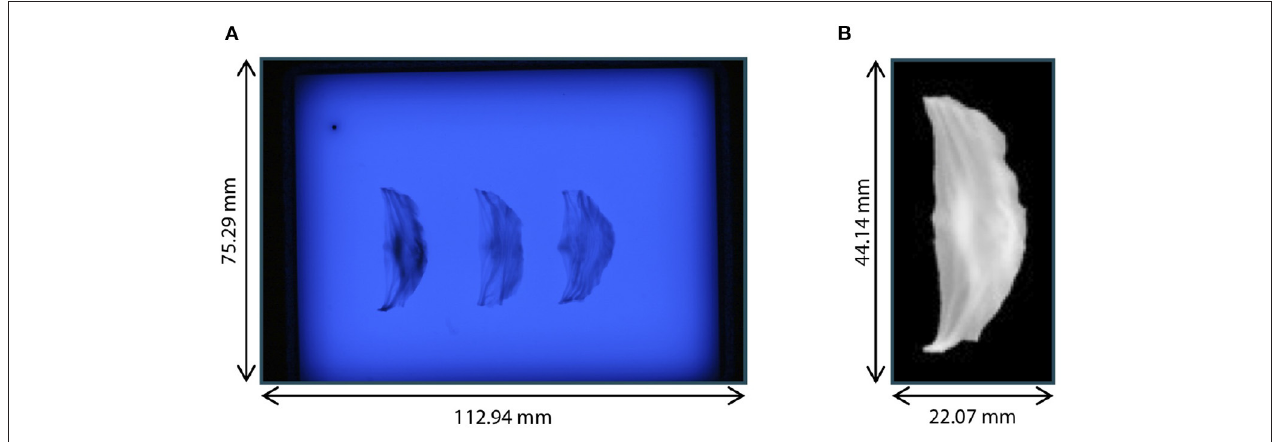
FIGURE 2 | Leaflet image acquisition. (A) Raw photograph of illuminated plate with right-coronary, left-coronary, and non-coronary leaflet of one valve. (B) Right-coronary leaflet after